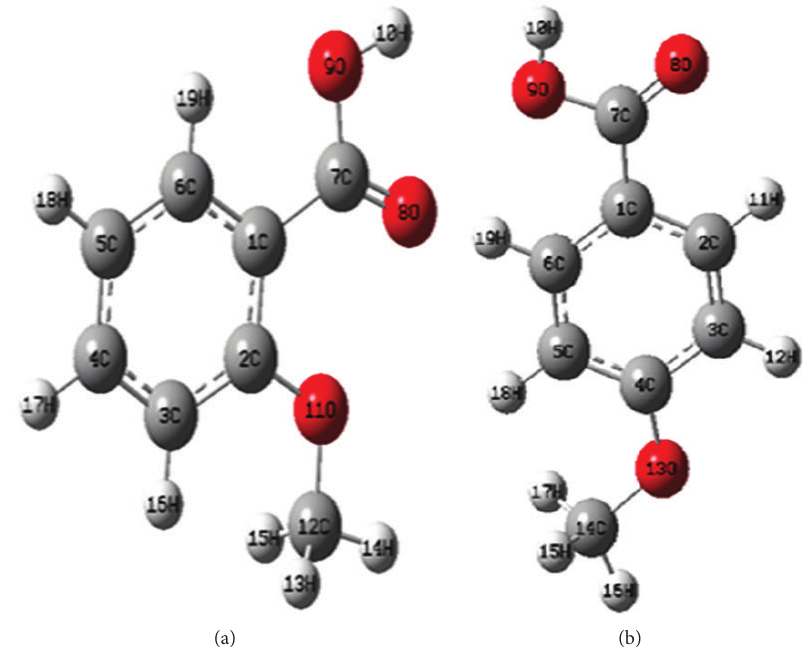
(a) (b) Figure 1: (a) Molecular structure of O-Anisic acid along with numbering of atoms. (b) Molecular structure of Anisic acid along with numbering of atoms.